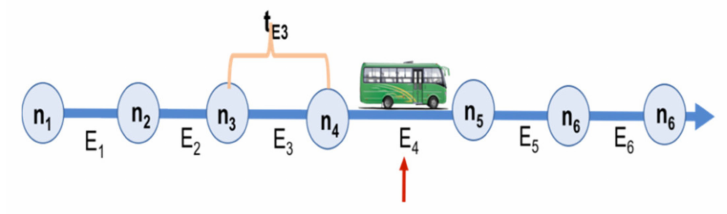
Figure 8. Time to travel an